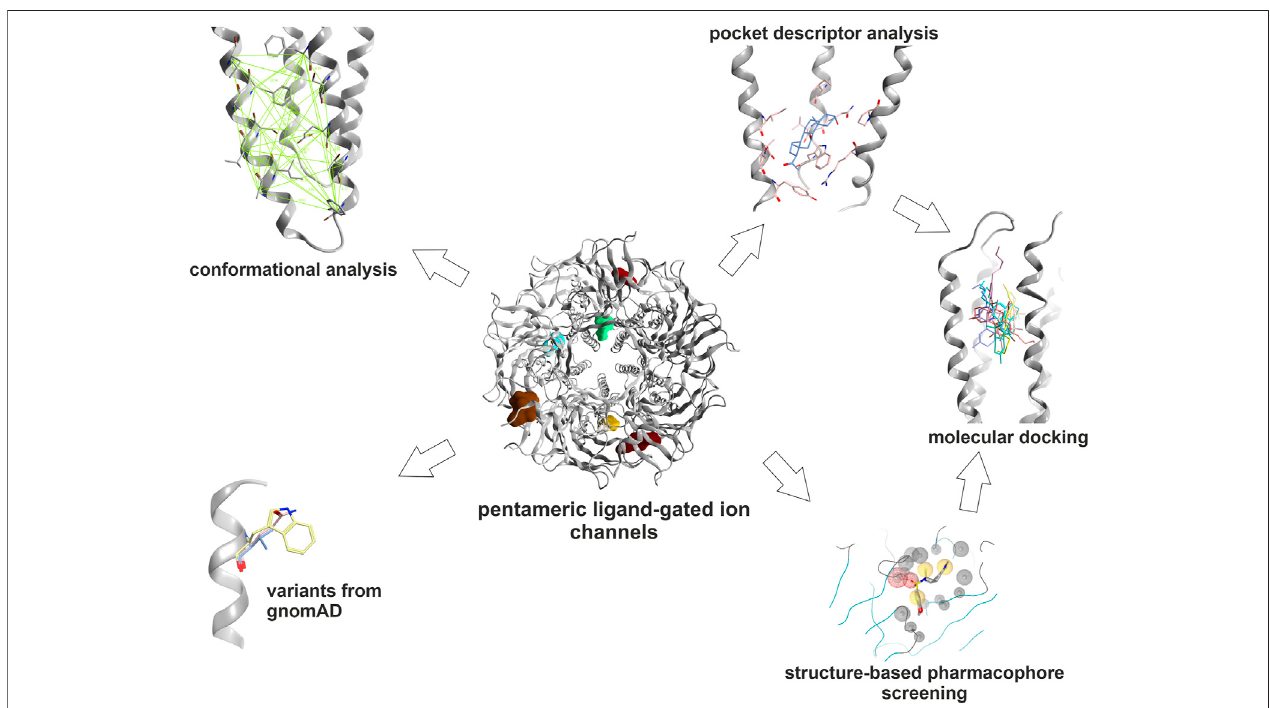
FIGURE2| Graphicalmethods:Thebindingsiteswhichwereselectedforthisstudyweresubjectedtoanarrayofcomputationaltools:Aminoacidscontributingto the pockets were extracted. Subsequently, local structure based alignments and sequence- to- structure alignments were employed to identify or predict their topological equivalents in the other subunits where possible. These pocket forming segments were then subjected to local sequence similarity and pocket descriptor computation. Hierarchical clustering of pairwise euclidean distances between pocket descriptor coordinates was performed to predict similarities (see Methods ). Pocketconformationswereanalyzedinordertoguidetheselectionofstructuresforcomputationaldocking.Therelativeabundanceofvariantsatandnearligandbinding sites was extracted from gnomAD. Structure based pharmacophore screening was employed to derive selected bound state hypotheses to complement the pocket analysis. For dronabinol (the phytocannabinoid Δ 9 -THC), multimodal predictions from literature search, mining of Drug Central, pharmacophore screening and pocket similarity predictions were ranked and strong candidates were followed op with homology modeling and computational